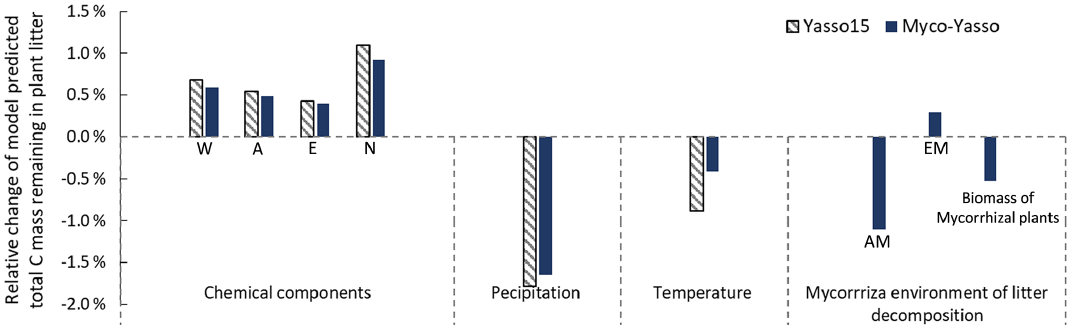
Figure 7. Model sensitivity to 1% increase in model input values. Impacts of input parameters are shown in terms of the relative change in total C remaining after 10 years of decomposition. The “AM” bar shows the impact of an increase in AM plant biomass by 1%, while EM plant biomass remains unchanged. The “EM” bar shows the impact of an increase in EM plant biomass by 1%, while AM plant biomass remains unchanged. The “Biomass of mycorrhizal plants” bar shows the impact of an increase in the combined biomass of AM and EM plants by 1% while the AM and EM distribution within the vegetation remains